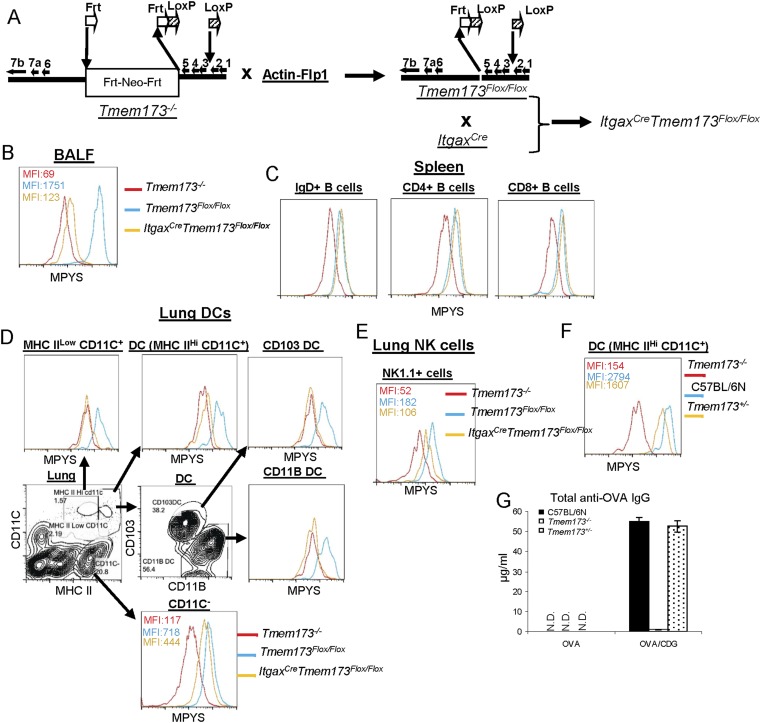
Generation of ItgaxCreTmem173Flox/Flox mouse.